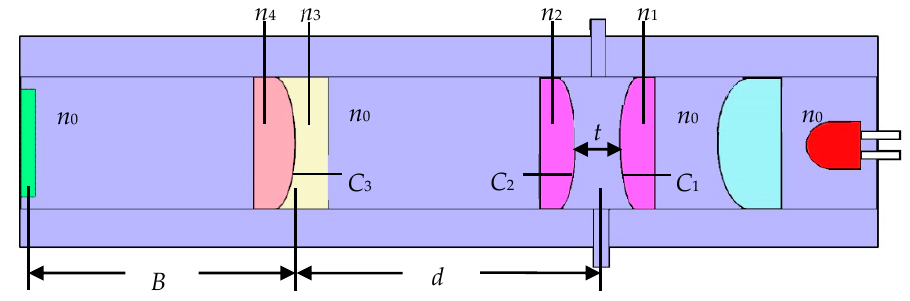
Figure 2. Mathematical model of the system.